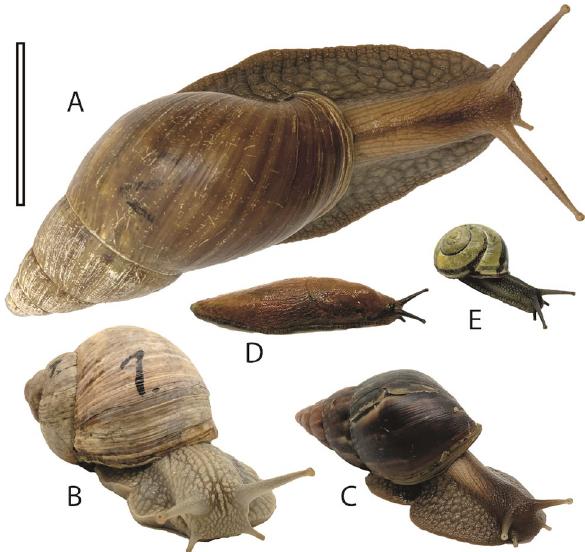
Figure 1. Mollusc species used in this study. ( A ) Mature Lissachatina fulica . ( B ) Helix pomatia . ( C ) Immature Lissachatina fulica. ( D ) Arion vulgaris . ( E ) Cepaea nemoralis . Scale bar = 4